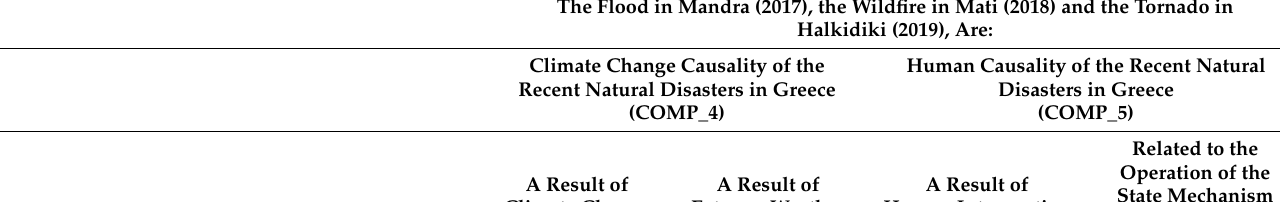
Table 7. Correlation analysis between risk perceptions of climate change, perceptions of personal effects of climate change and perceptions of the effects of climate change and the perceptions of the causes of the recent natural disasters in Greece.